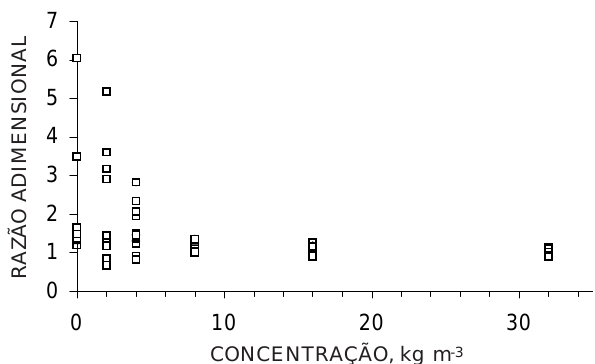
Figura 4. Relação adimensional dos parâmetros indicados nos quadros 5 e 6 em função da concentração de